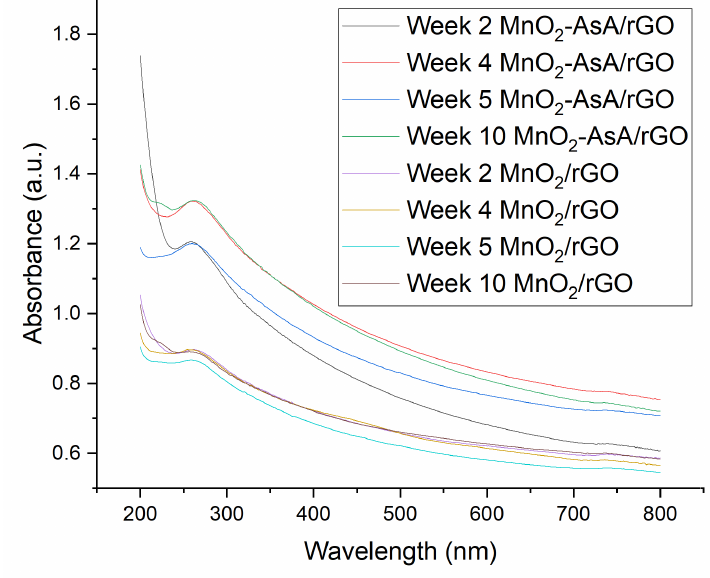
Figure 10. Absorbance versus wavelength of nanofluids during